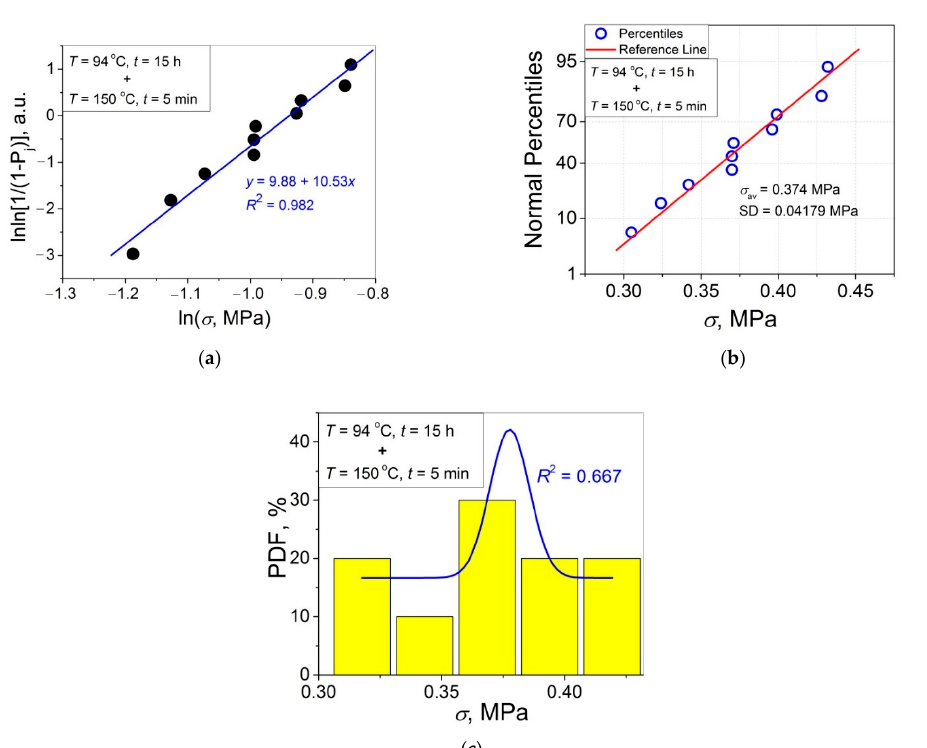
Figure 10. ( a ) Linear regression fit of the lap shear strength σ in Weibull’s coordinates; ( b ) normal probability plot; ( c ) probability density function (PDF) vs. σ fitted with a Gaussian function for an amorphous PET–PET interface self-bonded at T = 94 °C for t = 15 h and at T = 150 °C for t = 5 min.